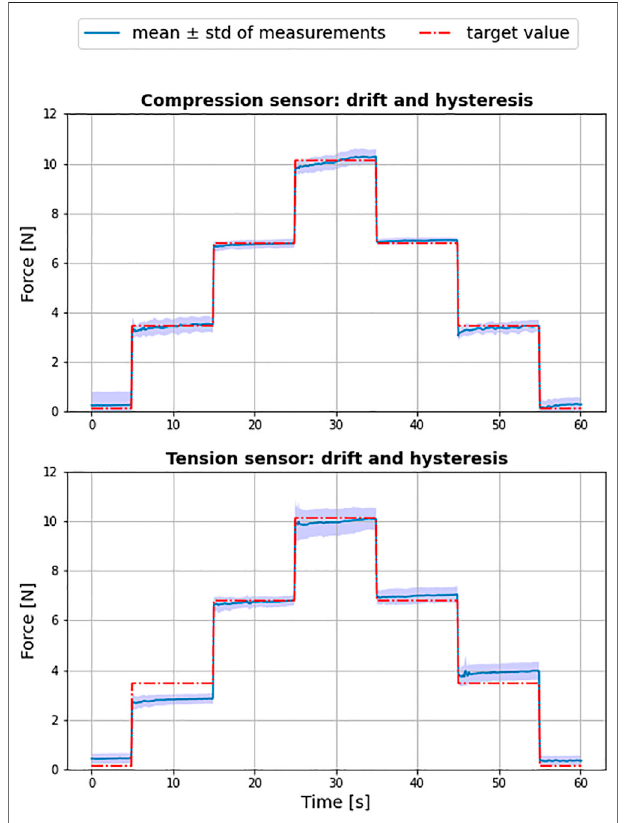
FIGURE 11 | Result of force sensor tests for tension (sensor 1) and compression (sensor 2) over ten independent test cycles.